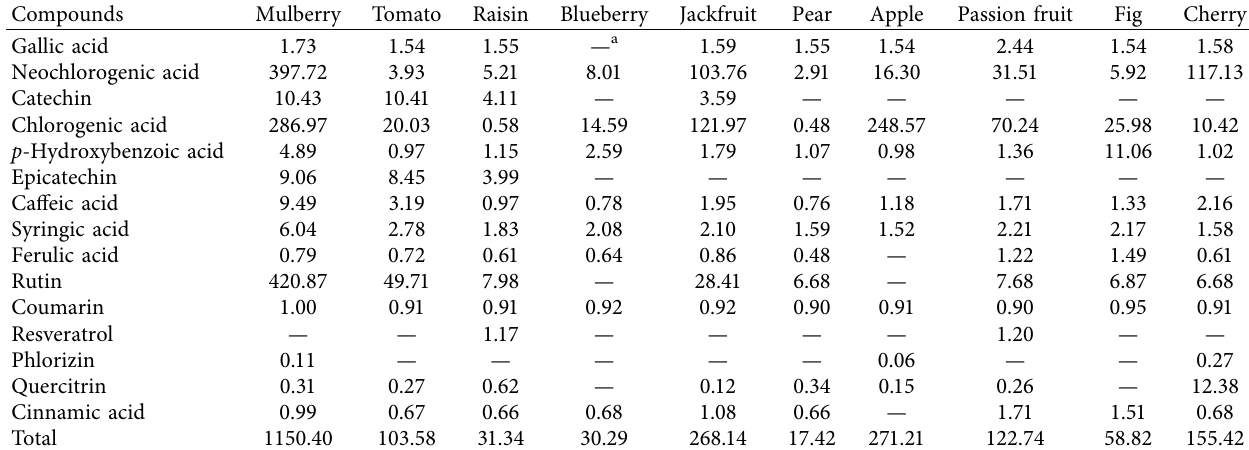
Table 4: The content of polyphenols analyzed by proposed method in fruit juice samples ( μ